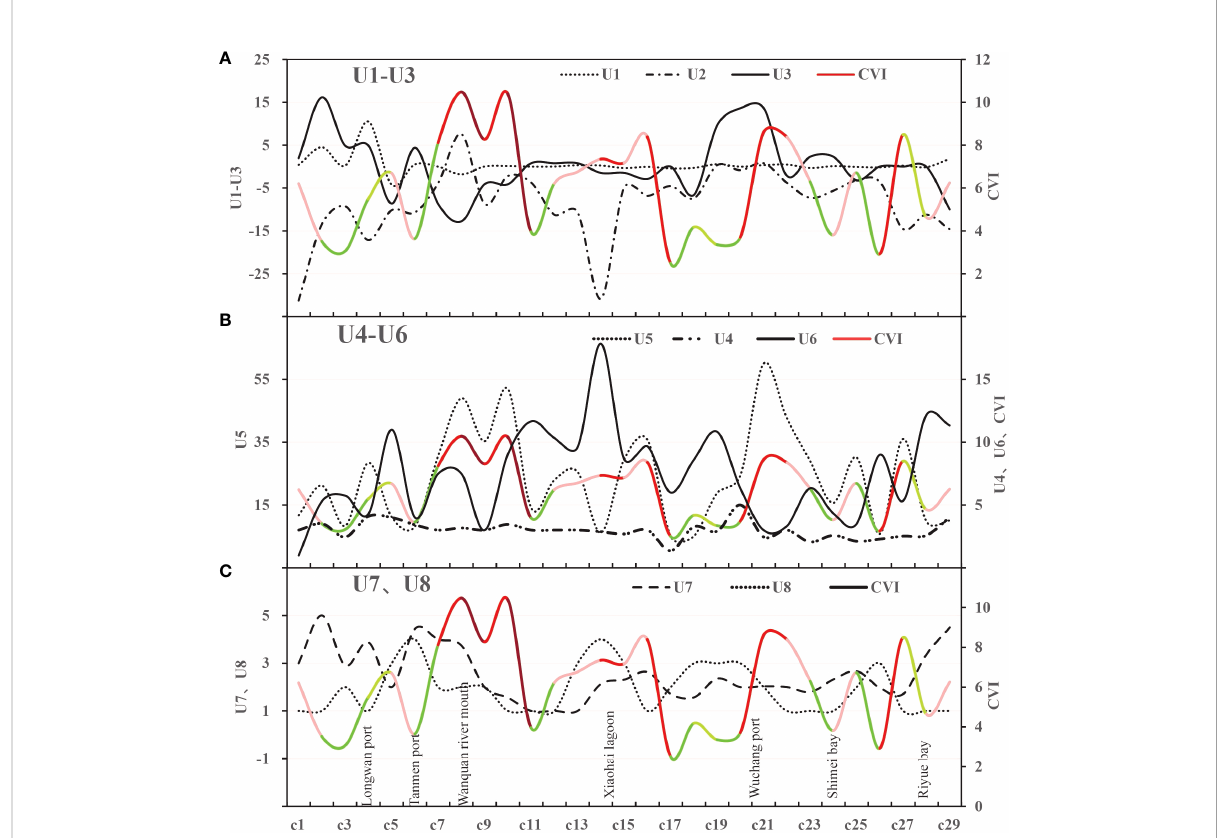
FIGURE 7 Vulnerability index and evaluation factor curve (The color of CVI curve corresponds to its vulnerability degree). (A) The relationship between U1- U3 index and CVI curve. (B) The relationship between U4-U6 index and CVI curve. (C) The relationship between U7, U8 index and CVI